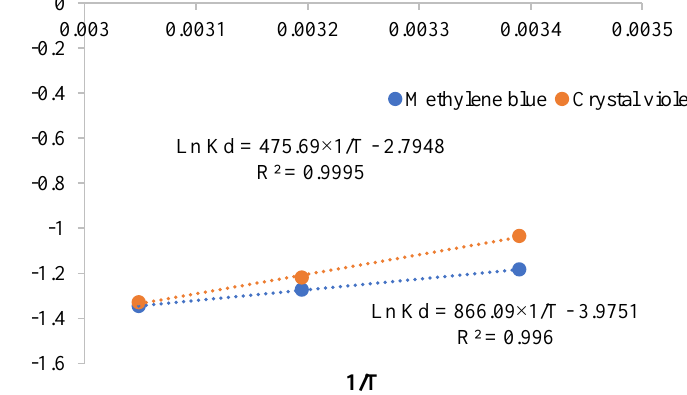
Ln Kd = 475.69×1/T - 2.7948 R² = 0.9995